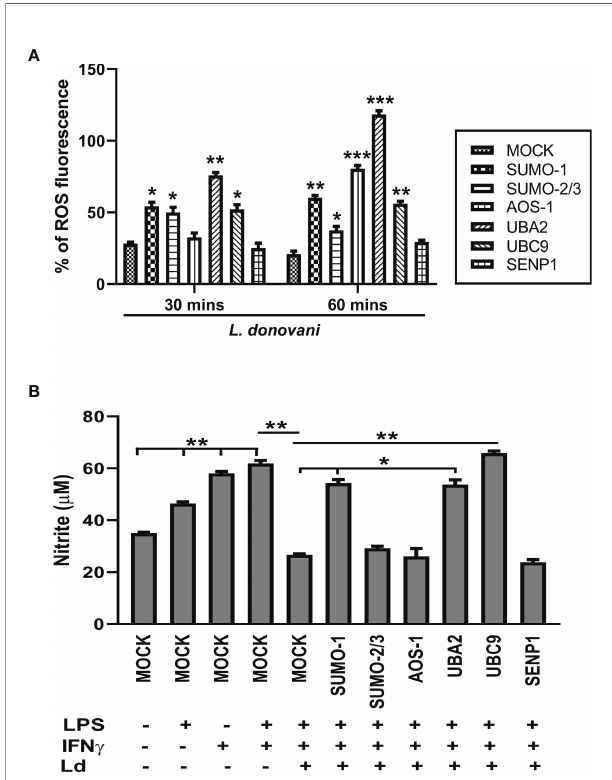
FIGURE 5 | Host SUMOylation favors Leishmania donovani survival by modulating the generation levels of ROS and nitric oxide. THP-1-differentiated human macrophages were transfected with siRNAs for 36 h (A) in a 96-well plate followed by the infection of L. donovani promastigotes at 20 MOI for 30- and 60-min time points. Thirty minutes before completing the incubation period, cells were loaded with 10 µM of DCFH-DA. Samples were immediately analyzed for ROS levels by fl uorometry with excitation/emission at 485/535 nm. The graph was plotted in GraphPad Prism 8. Statistical signi fi cance was quanti fi ed using the unpaired t-test with Welch ’ s correction, * p = 0.02, 0.05, and 0.04 for MOCK vs. SUMO-1 , SUMO-2/3 , and UBC9 , respectively; ** p = 0.005 for MOCK vs. UBA2 at 30 min post-infection and * p = 0.02 for MOCK vs. SUMO- 2/3 ; ** p = 0.003 and 0.004 for MOCK vs. SUMO-1 and UBC9 , respectively; *** p = 0.001 and 0.0007 for MOCK vs. AOS-1 and UBA2 , respectively, at 60 min post-infection. (B) Transfected macrophages were infected with L. donovani promastigotes at 20 MOI along with the stimulation of LPS (100 ng/ ml) and hIFN- g (20 ng/ml) for 24 h Griess reagent was used to estimate the NO level in the supernatant. The graph was plotted in GraphPad Prism 8. Statistical signi fi cance was quanti fi ed using the unpaired t-test with Welch ’ s correction (* p < 0.05 and ** p < 0.01). ROS, reactive oxygen species; MOI, multiplicity of infection; LPS,